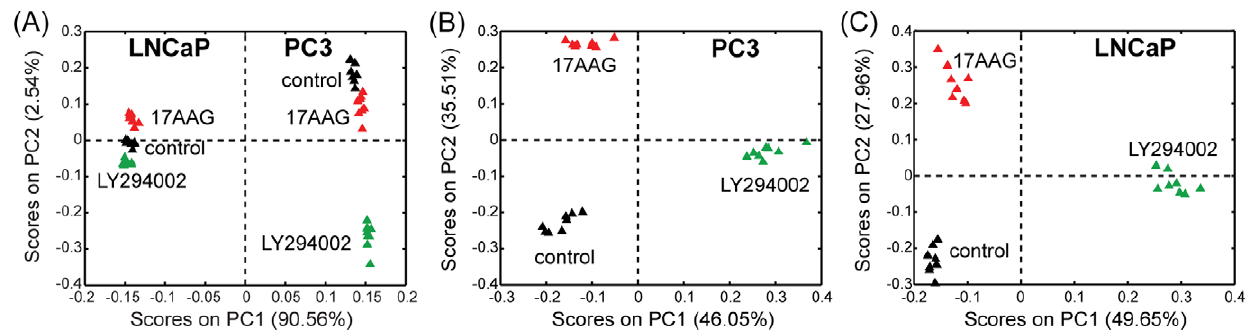
Figure 2. Multivariate statistical analysis of the MR spectra. Scores plots (PC1 vs PC2) obtained by performing PCA on the MR spectra acquired on polar extracts (8 replicates per treatment condition) of (A) both PC3 and LNCaP cells, and individual (B) PC3 and (C) LNCaP prostate cancer cells following a 48-hrs treatment with DMSO (solvent control, black), LY294002 (green) and 17AAG (red).